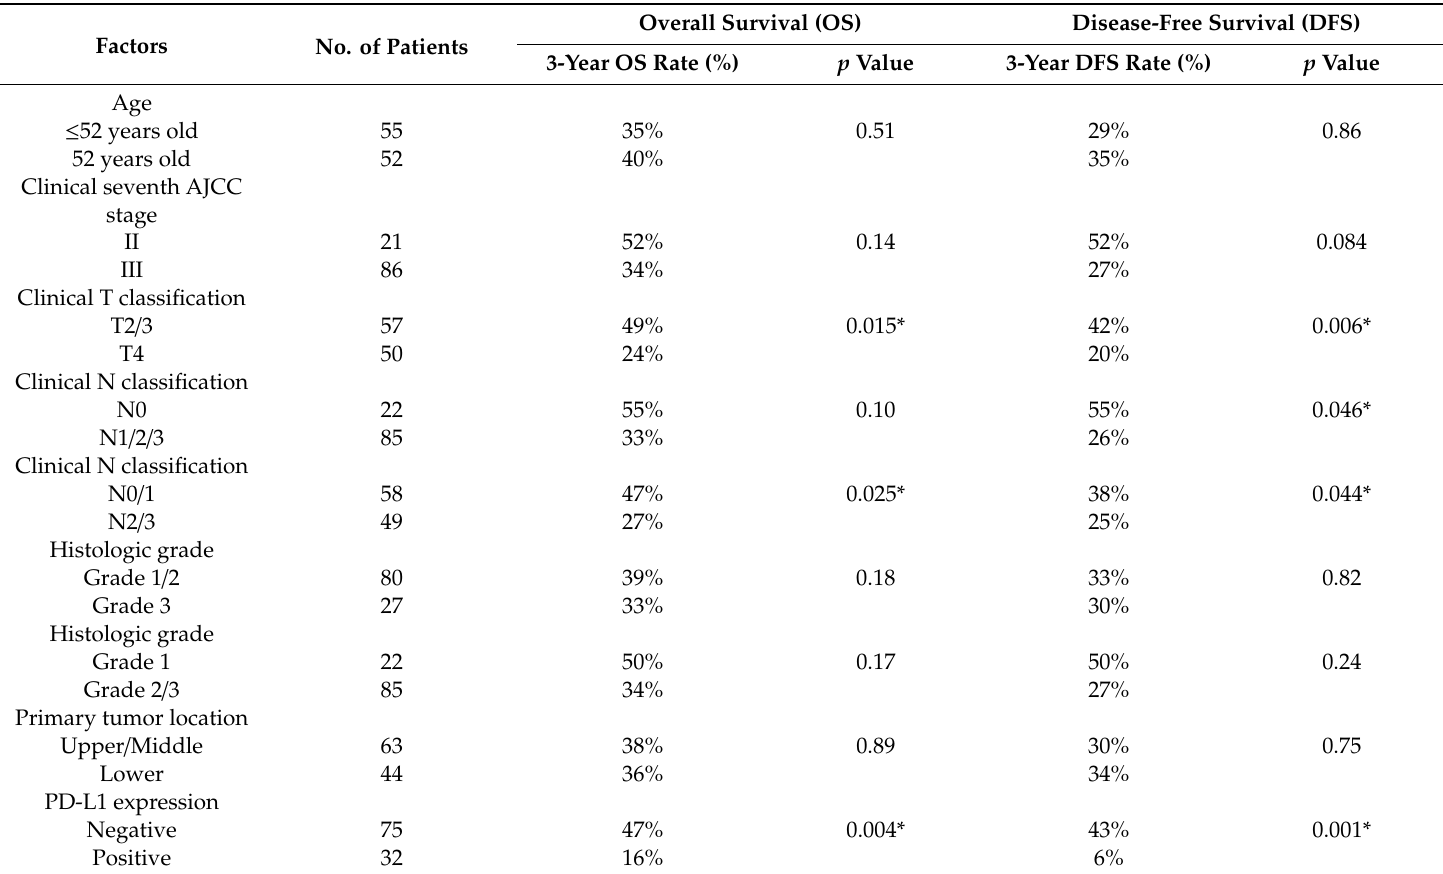
Table 4. Results of univariate log-rank analysis of prognostic factors for overall survival and disease-free survival in 107 patients with locally advanced esophageal squamous cell carcinoma who received preoperative